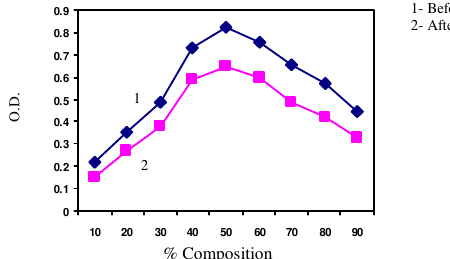
Figure 5 . Plots of O.D. vs. % composition of metal ions -Pr(III)